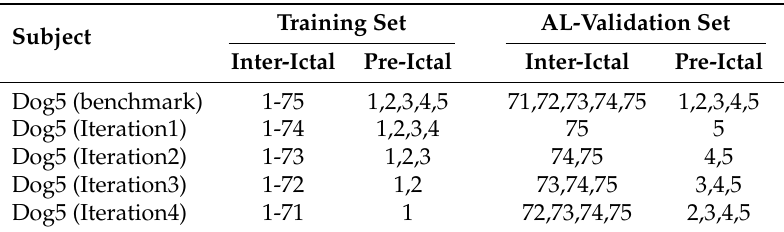
Table 11. Selection of data blocks for validating active